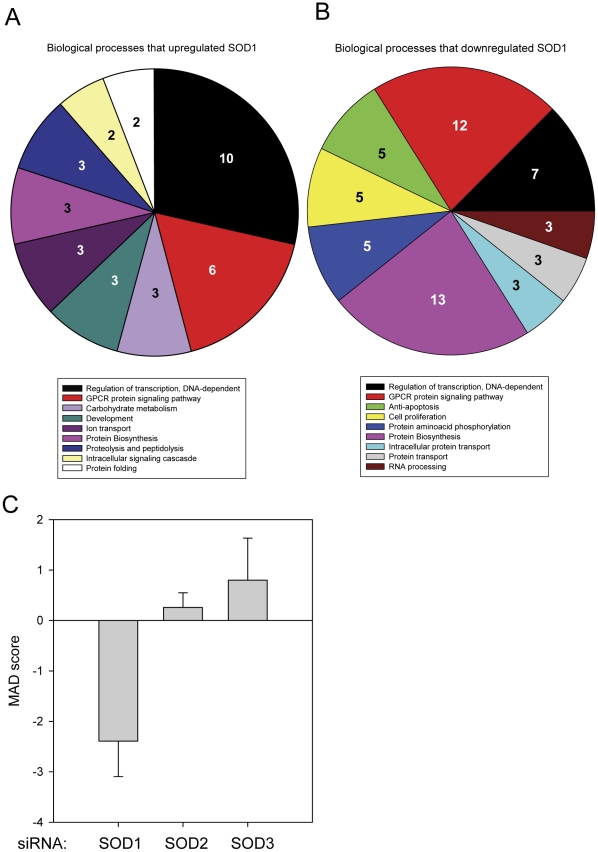
Classification of prominent regulators of SOD1 in the RNAi screen.
A & B) Pie charts representing annotated biological process of proteins identified as regulators of SOD1. Contribution of each biological process as a percentage of total are shown. Contributions of processes that are less than 2% of the total are not shown in the figure. C) Effect of siRNA knockdowns of SOD1 isoforms in the screen. The MAD score values of the three SOD1 isoforms obtained in the screen are shown. The error bars represent SD.